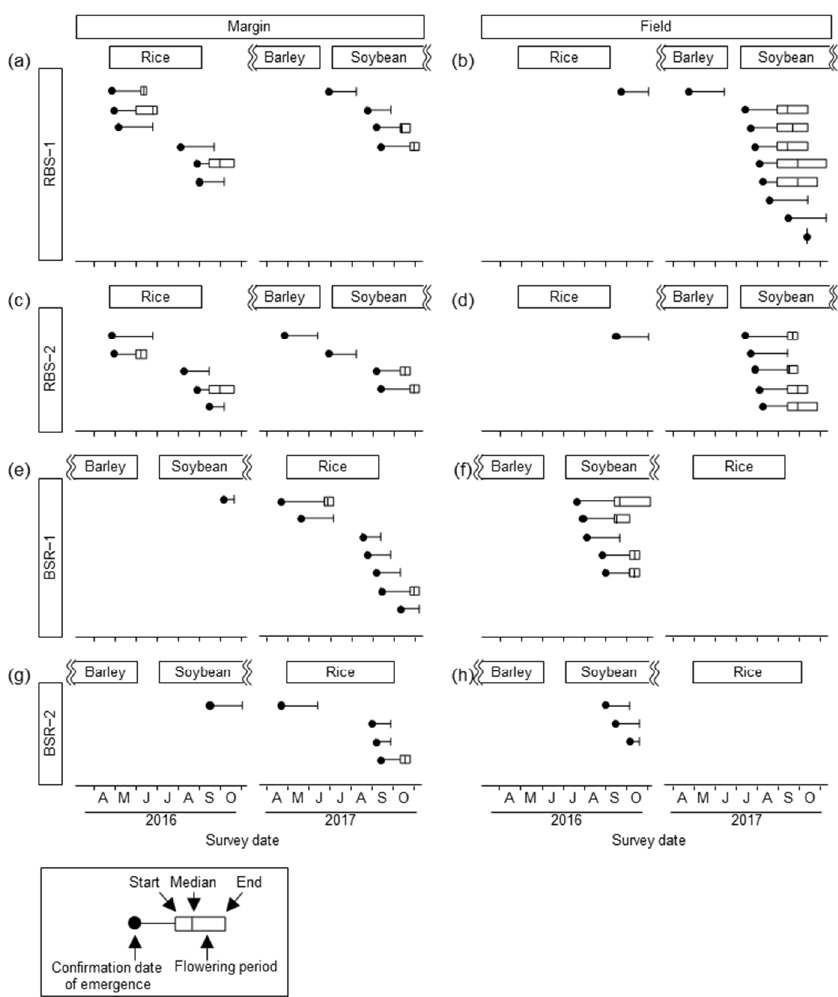
Figure 3. Relationship between confirmation date of emergence and flowering time of entireleaf morning glory. Field margin ( a ) and field ( b ) of RBS-1; field margin ( c ) and field ( d ) of RBS-2; field margin ( e ) and field ( f ) of BSR-1; field margin ( g ) and field ( h ) of BSR-2. The set of black circle(s), horizontal bar(s), and rectangle(s) within a bar represent the growth stage(s) of a subpopulation of one cohort (bottom left area bounded by a square). Black circle, confirmation date of emergence; horizontal bar between the black circle and the square, vegetative growth stage; left end of the rectangle, start of flowering; right end of the rectangle, end of flowering; bar inside the rectangle, median of the flowering period. RBS-1, rice–barley–soybean-1; RBS-2: rice–barley–soybean-2;